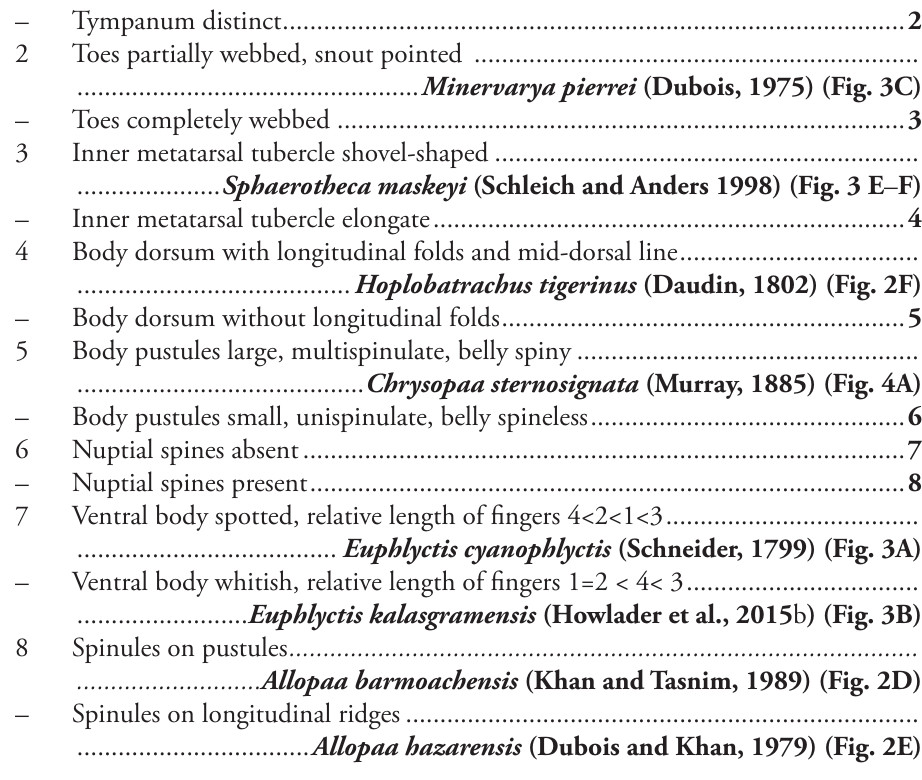
Statistical comparisons of Sphaerotheca populations Of the studied 23 morphometric measurements in S. maskeyi , we obtained from our PCA 10 and eight significant variables ( r > 0.90) in males having uniform rusty-colored dorsum and having dotted pattern, respectively. We obtained 10 and one significant variables ( r > 0.90) in females, respectively. Eigen value, variability (%), cumulative vari- ability (%), and factor loadings of the 23 morphometric measurements are given Table 1. The multivariate generalized linear model revealed statistically significant differ- ence ( F = 1876.60, P = 0.018; Wilk’s Λ = 0.00, partial η 2 = 0.97) in the morpho- (1, 11) metric measurements of males but non-significant in the females ( F = 0.944, P (13, 11)